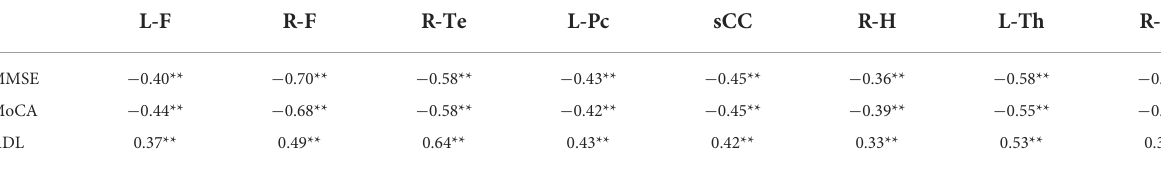
TABLE 4 Pearson’s correlations of T1 relaxation times with neuropsychological tests.